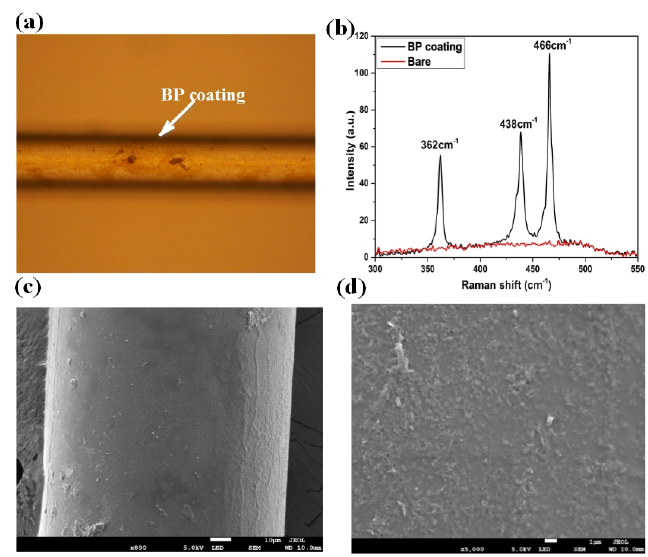
Figure 4. The ( a ) optical microscope image, ( b ) Raman spectrum, and scanning electron microscopy (SEM) pictures with ( c ) 800× and ( d ) 5000× magnification of the black phosphorus (BP) film coated weakly tilted fiber Bragg grating (WTFBG)